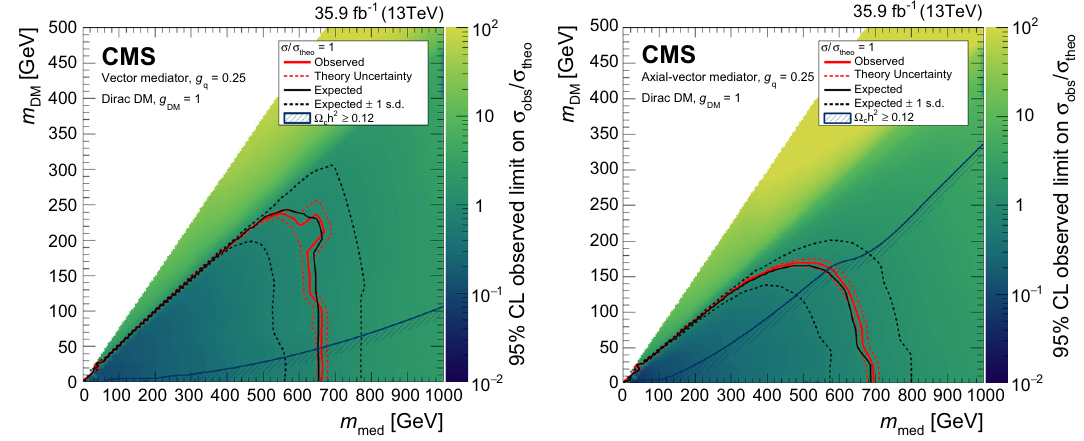
Fig. 5 The 95% CL expected and observed limits on σ obs /σ theo for the vector (left) and axial-vector (right) mediators with g q = 0 . 25 and g DM = 1. Limits are not shown for far off-shell (2 m DM > 1 . 5 m med ) regions of the parameter space